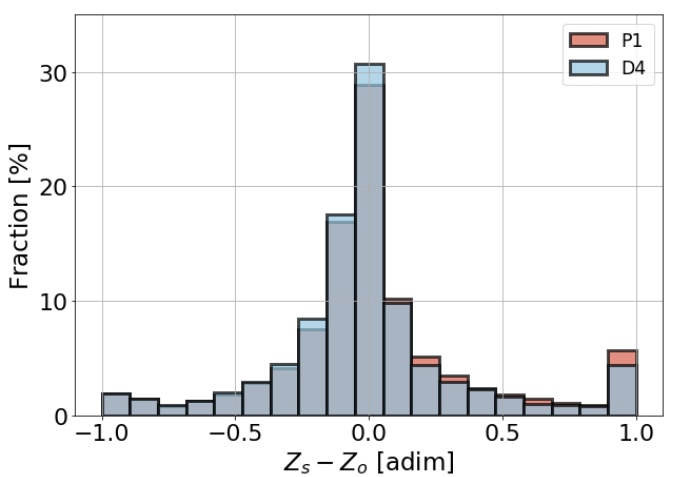
Figure 12. Histograms of the standardized peak flows difference for the D4 (blue) and P1(red) sce- narios.